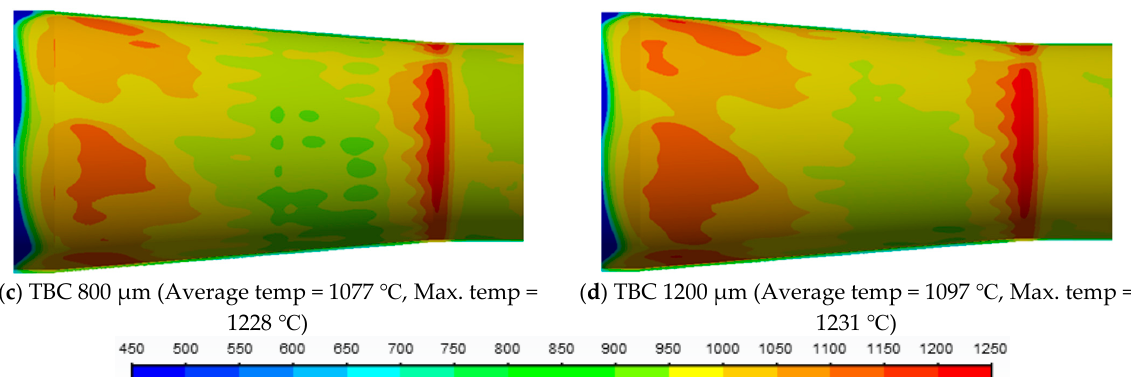
Figure 11. TBC surface temperature distribution based on the TBC thickness exposed to hot gas. Figure 12 shows the inner CL metal surface distribution based on the different TBC thicknesses on the combustion side. By increasing the TBC thickness, the metal surface temperature of the CL was reduced to 912 °C (1200 μ m TBC case) from 1029 °C (without TBC). When comparing the maximum temperatures, a similar trend was observed. When the contours in Figures 11 and 12 were compared based on TBC thickness between the TBC surface and metal surface, the metal temperature was reduced due to the low thermal conductivity of YSZ. Thus, the increasing TBC thickness provided good thermal protec- tion. Furthermore, as TBC thickness increased, the larger hotspot with a higher tempera- ner surface. However, the metal surface near the C-channel of the 1200 μ m case had a but a lower temperature than the other TBC cases in Figure 12a–c. The uniform distribu- tion of the wall temperature can help to mitigate the structural damage.